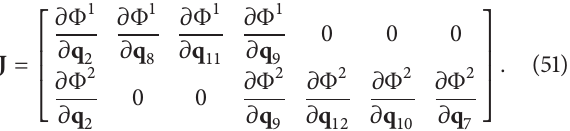
Figure 10: Angles of the links in the 50-link chain.